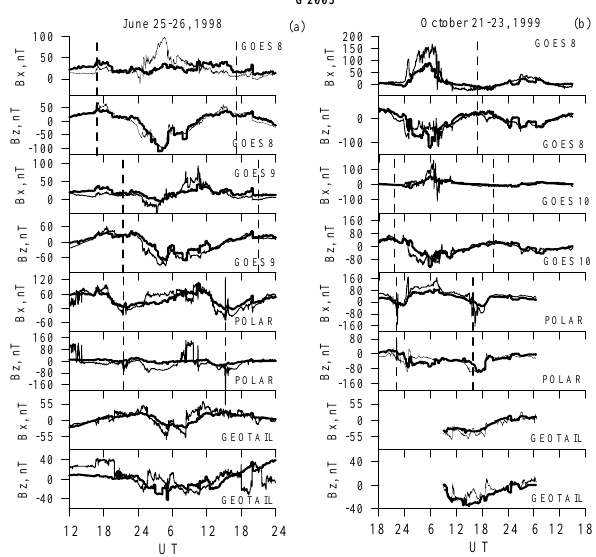
Fig. 4. Observed and model magnetic fields in the same format as in Fig. 3 for the event-oriented model G2003.